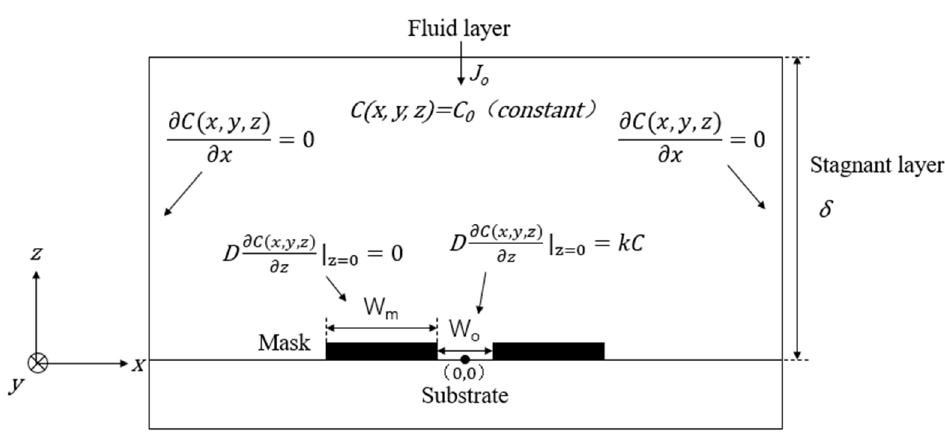
Figure 3. Schematic diagram of the 3D vapor-phase diffusion model.